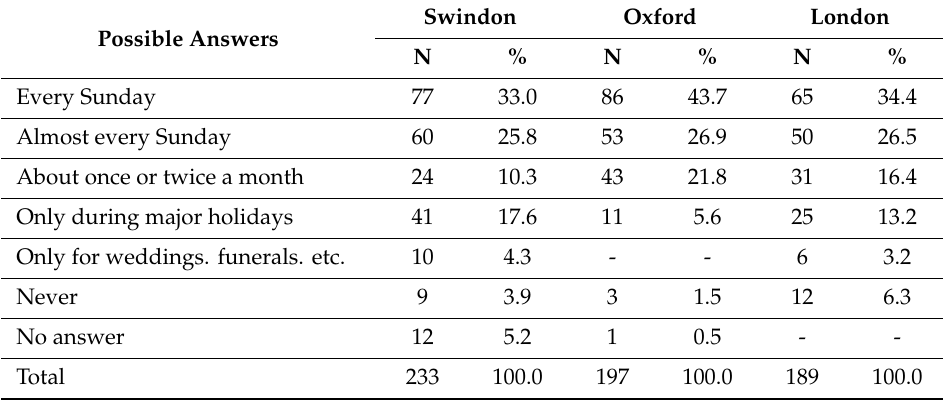
Table 3. How often did you attend a Holy Mass at the church over the last